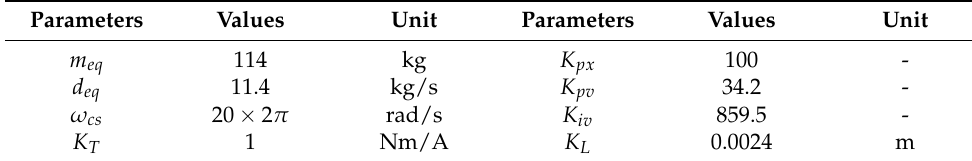
Table 1. Parameters for simulation studies.